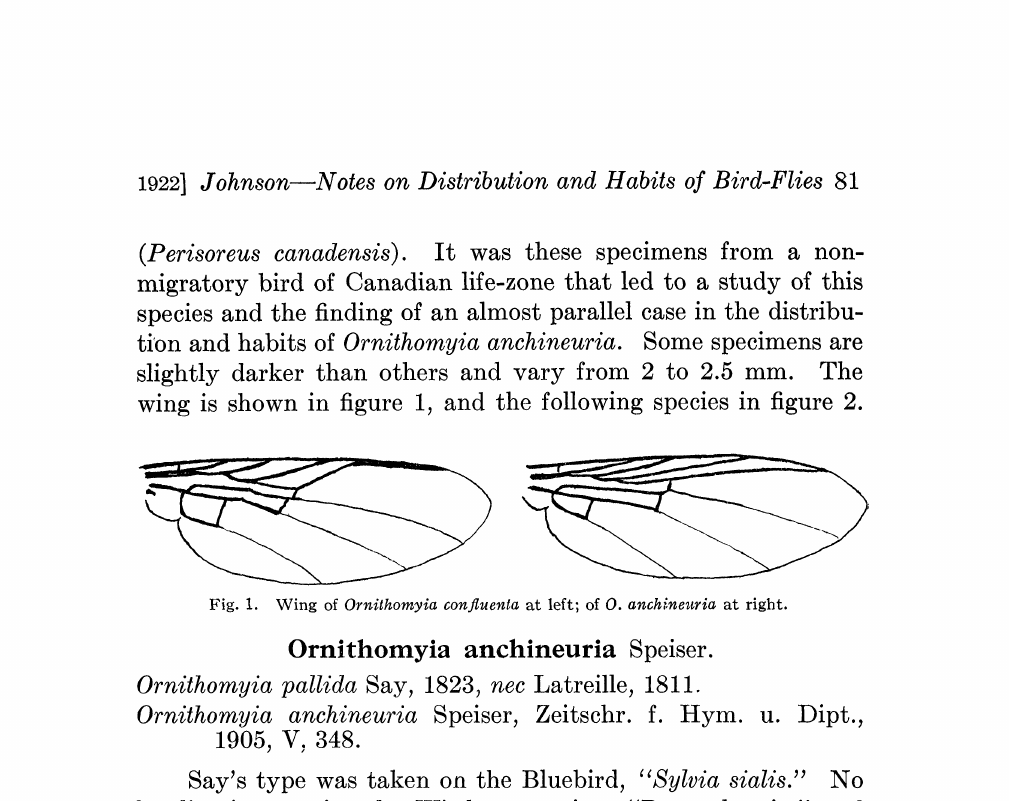
Fig. 1. Wing of Ornithomyia 6onfluenta at left; of O. anehneuria at right. Ornithomyia anchineuria